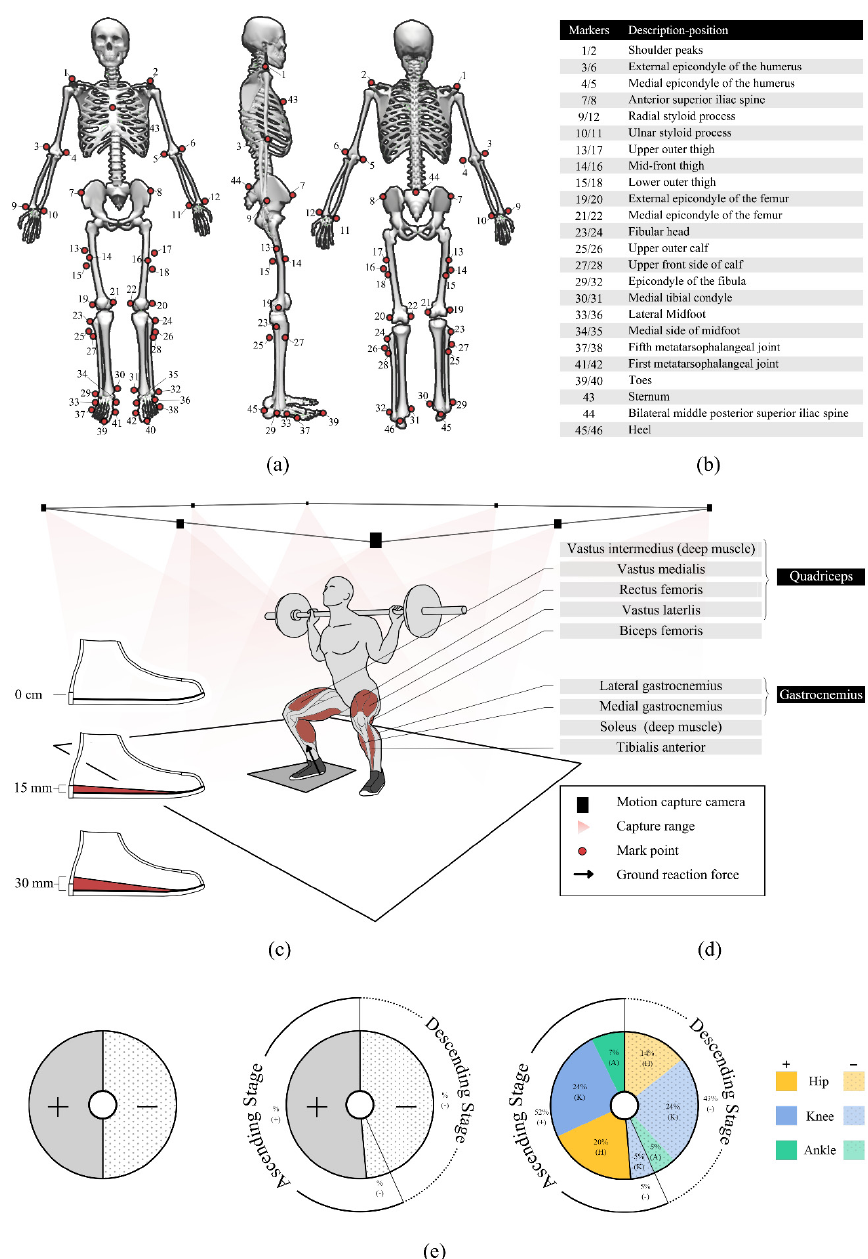
Figure 1. ( a ) Marking point paste location; ( b ) description of marker point location; ( c ) lab environ- ment, barbell squatting movements, major muscle groups, and heel life insoles; ( d ) major muscle descriptions and illustrations; ( e ) Creation of a CLEW method pie chart for barbell squats; ( e-left ) first, the pie chart is divided according to the positive and negative work done. Starting from the centerline, the positive work is on the left side of the circle (dark), while the negative work is on the right side of the process (light dot); ( e-middle ) secondly, the pie chart is divided according to the descending and ascending stages of the squatting movement. The dotted part of the outer circle indicates the descending phase of the squatting movement, and the solid line represents the ascending stage. The percentage of the relative positive or negative work in the absolute stage work is expressed in the outer ring; ( e-right ) finally, each relevant constituent work is designated as part of the pie chart, squatting down in the order of the hips, knees, and ankles, starting with the central reference line, and the colors and patterns inside the pie chart are used to distinguish joints and to separate positive work from negative